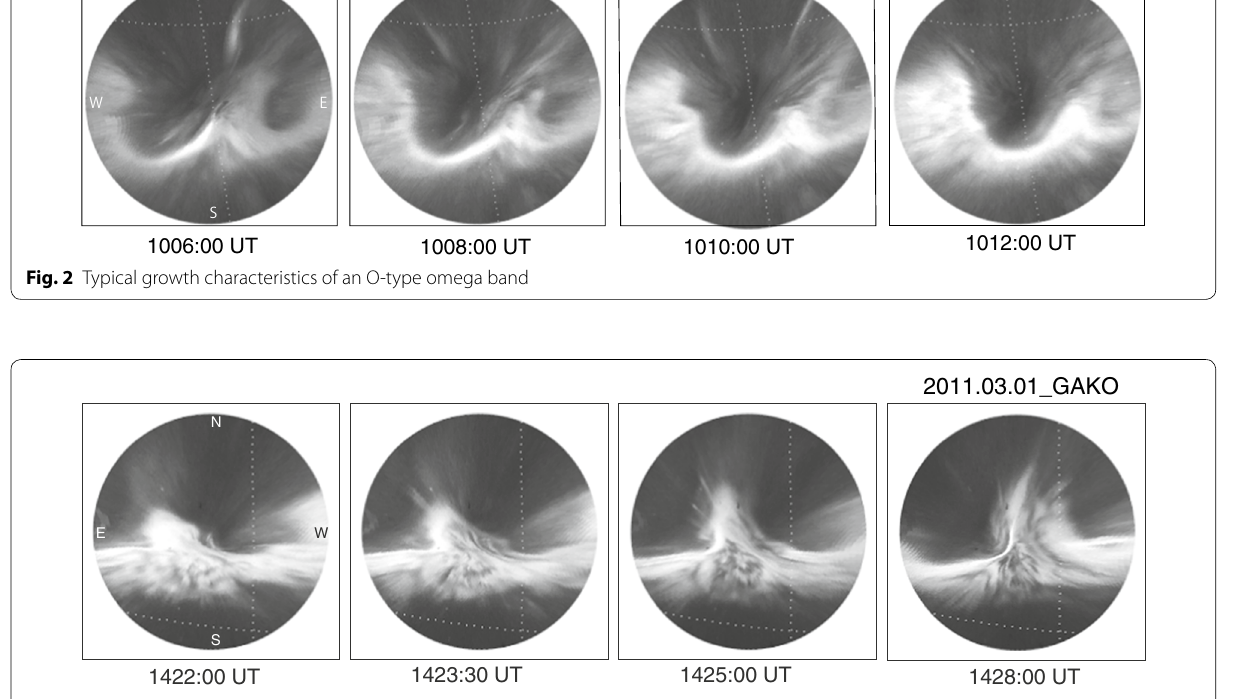
Fig. 3 Typical growth characteristics of a T-type omega